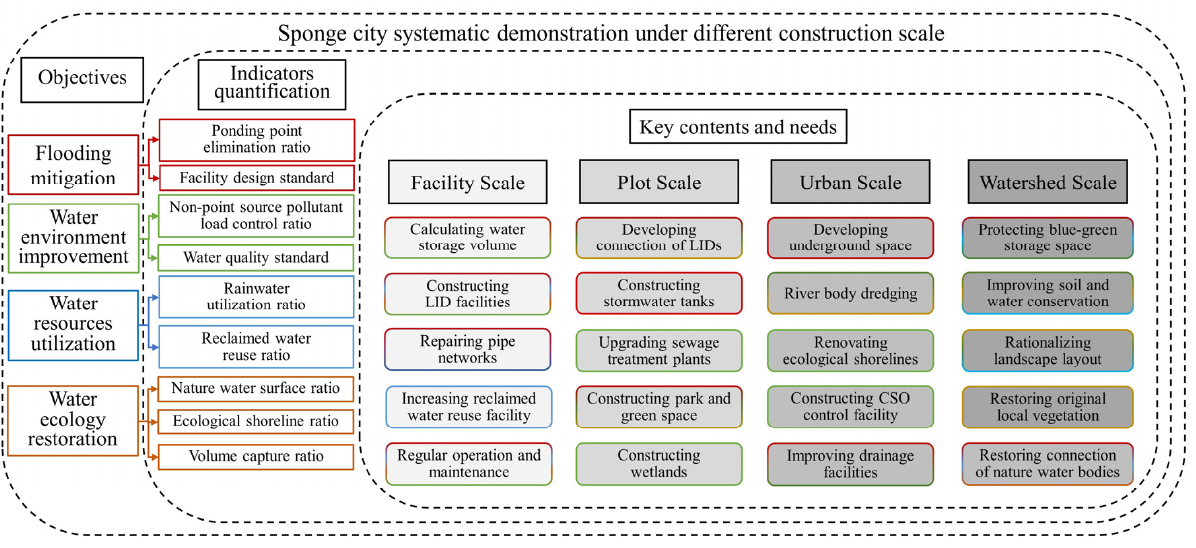
Figure 5. Objectives, indicators, key contents and needs for systematic demonstration of sponge city. Note: The colors of the boxes with different content and needs indicate that they can be used to improve the objectives or indicators under the same corresponding